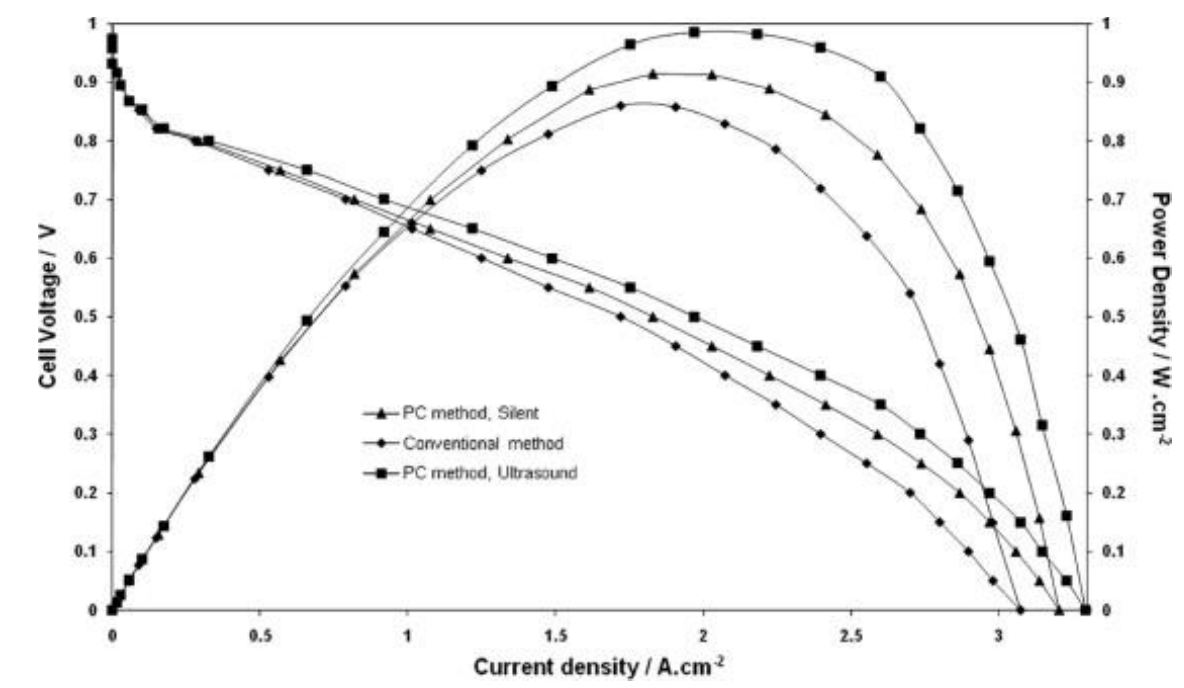
Figure 13. Comparison of MEA performance of anode electrodes prepared by galvanostatic pulse method without ultrasound (silent), sonogalvanostatic pulse method (ultrasound); and screen printing (conventional) method [196] (license no. 5172580641290).